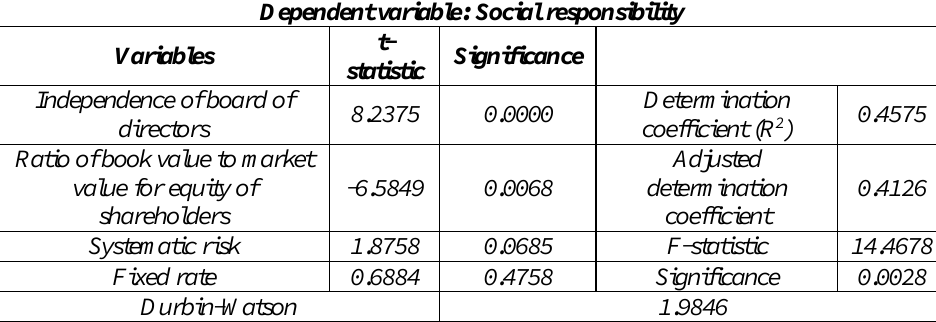
Table 5. The findings of approximation of regressive model related to the first